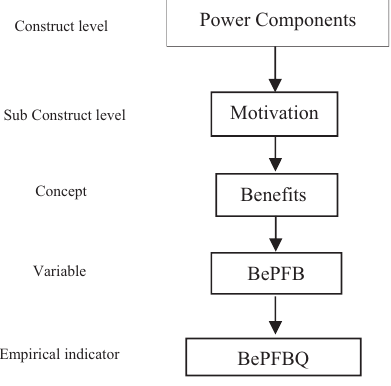
Figure 1. Theoretical substruction